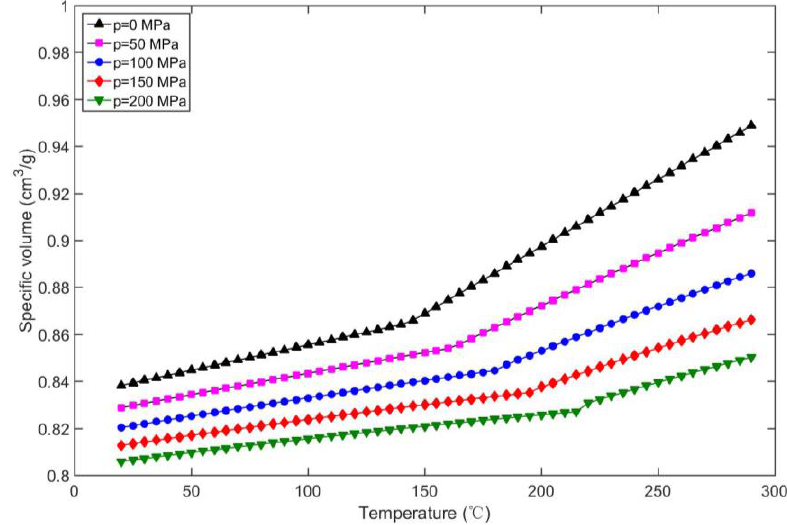
Figure 1. Specific volume vs. temperature of PC Lexan 105 .